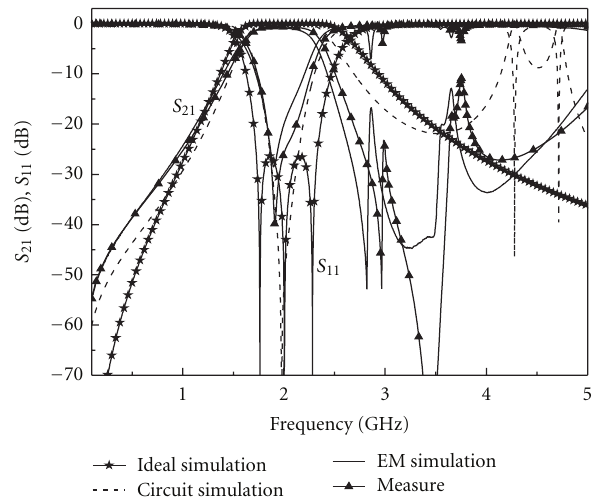
Figure 5: Frequency response of the filter of Figure 4. The circuit simulation has been achieved by means of Agilent ADS , considering lumped resonators coupled through 90 ◦ at the central frequency.